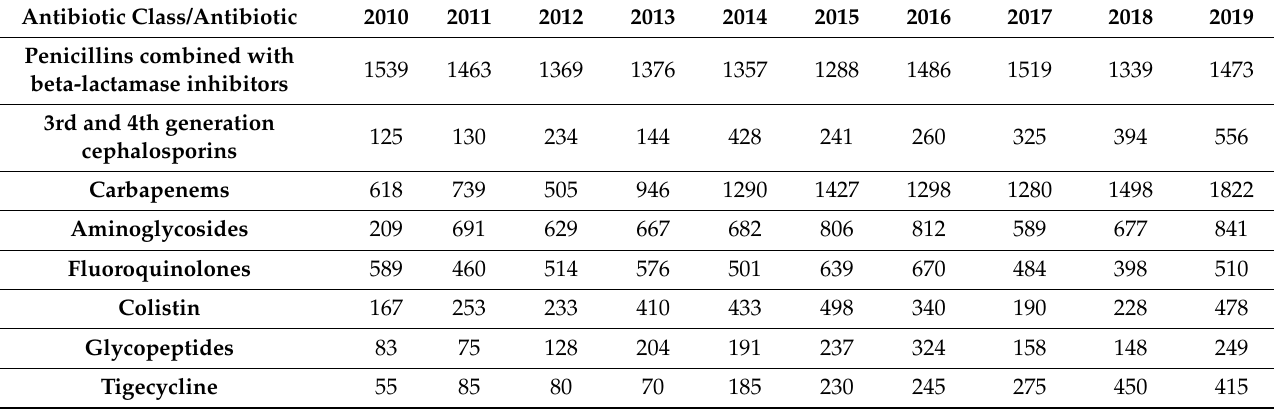
Table 12. Antibiotic consumption in defined daily doses (DDD) at the Department of Anesthesiology and Intensive Care Medicine. Antibiotic Class/Antibiotic